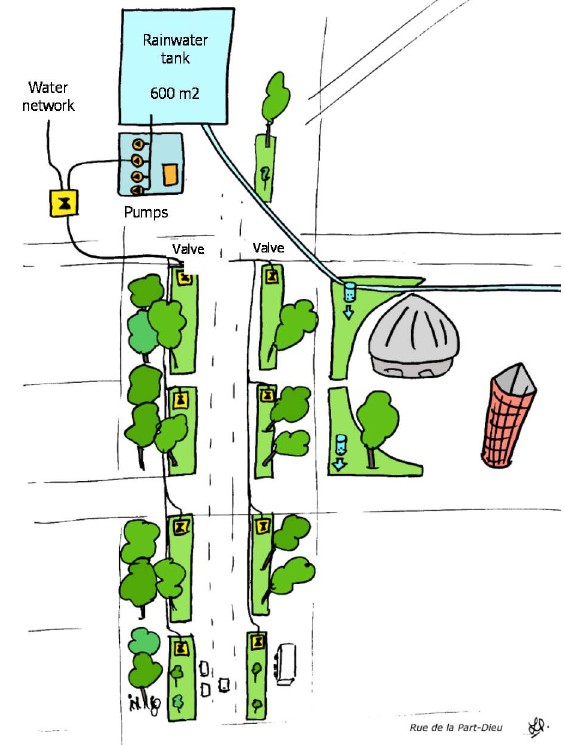
Figure 11. Garibaldi Street, overview of planted strips and irrigation